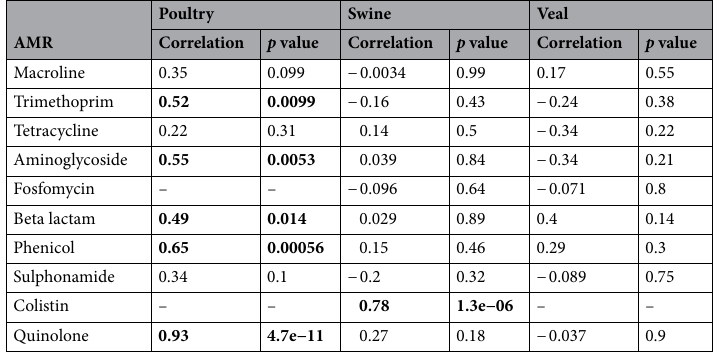
Table 1. Correlation and p value from regression analysis between abundance of AMR genes in metagenomic fecal samples and percentage of E. coli isolates carrying AMR genes. The bold value represents significant correlation between the abundance of AMR genes from metagenomic samples and single